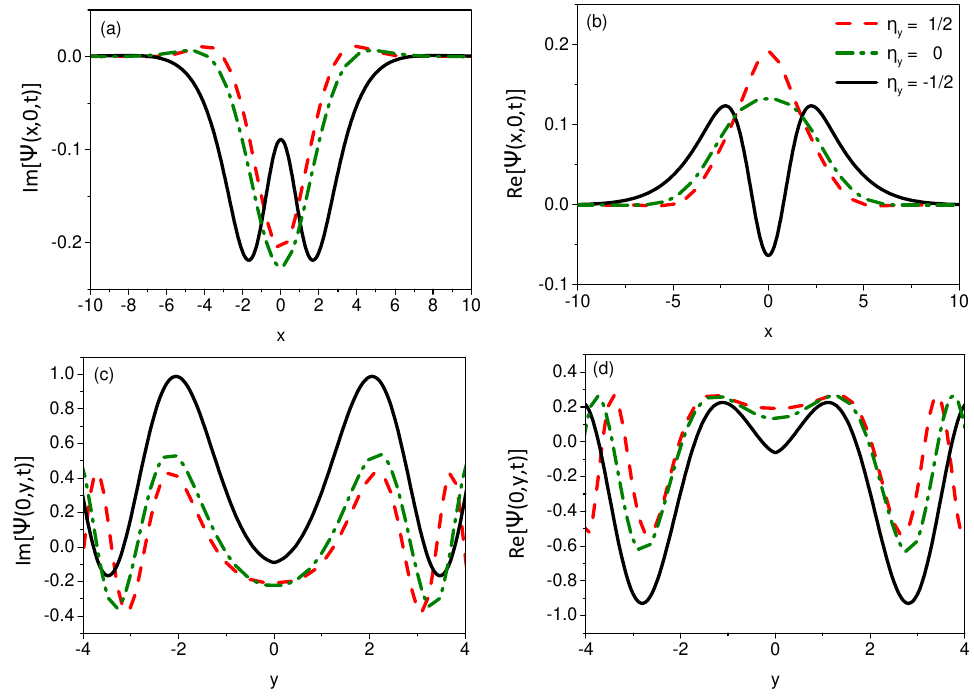
Figure 4. ( a ) Imaginary and ( b ) Real parts of Ψ ( x ,0, t ) vs. x for η (cid:48) y = − 1/2, 0 and 1/2. ( c ) Imaginary and ( d ) Real parts of Ψ ( 0, y , t ) vs. y for the same values of the parameters. The curves are depicted (cid:48) for ¯ ht / m = 1, l / t η y = 1, and the initial condition ϕ ( x , y ) = δ ( y ) e − x 2 / ( 2 σ 2 ) / (